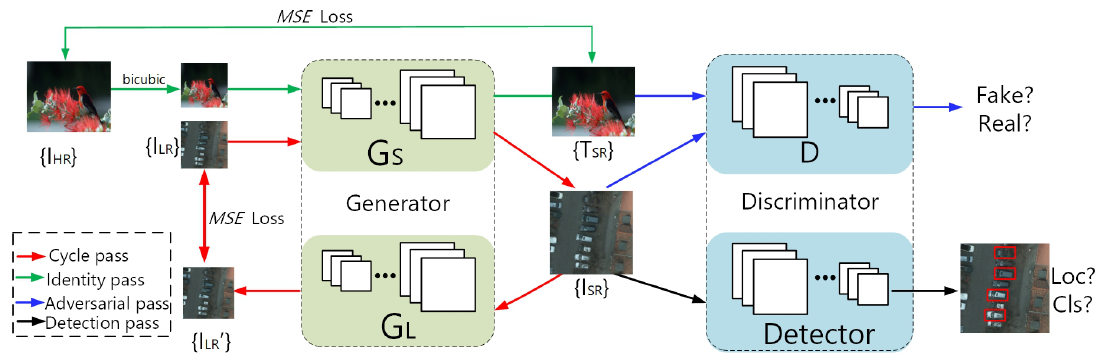
Figure 2. Illustration of our CycleGAN-based vehicle detection module(CVDM). I LR is the input LR image, I SR is the super-resolved image from I LR , I (cid:48) is of LR generated from I SR . T HR is the HR image provided as reference from other LR high-quality dataset. T LR is down-sampled version of T HR . T SR is the super-resolved HR image from T LR . Colored arrows represent different parts in the whole framework.